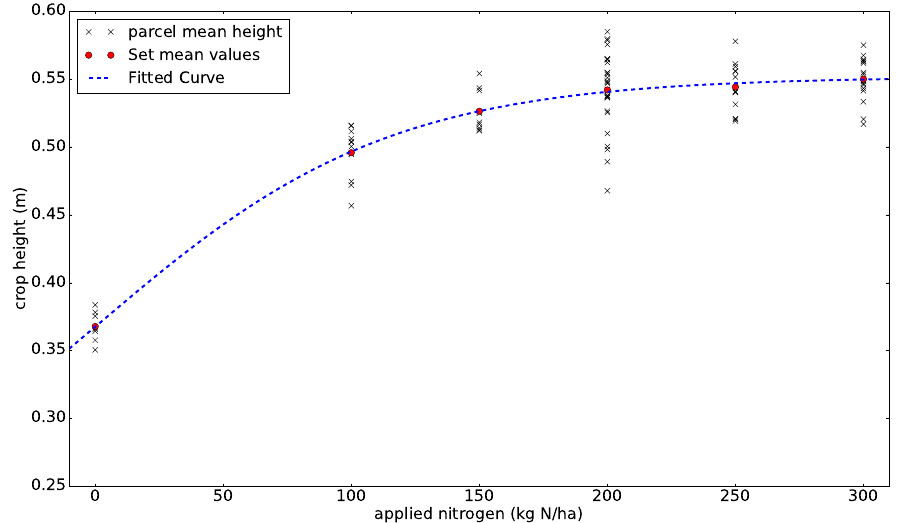
Figure 10. Relationship between crop height and nitrogen, and the model with estimated parameters.